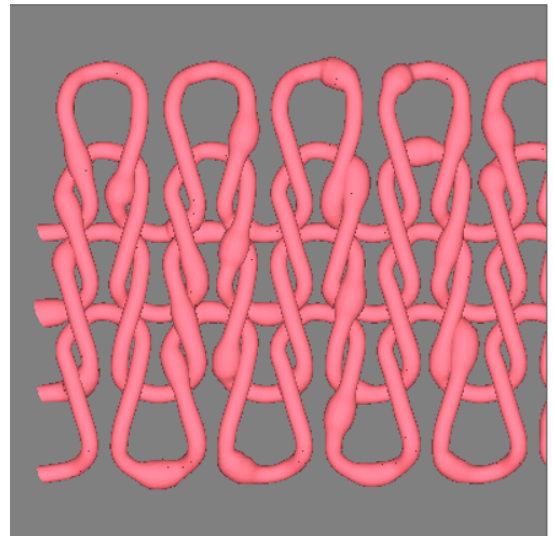
Figure 19. Weft-knitted structure with 3D slub yarns.